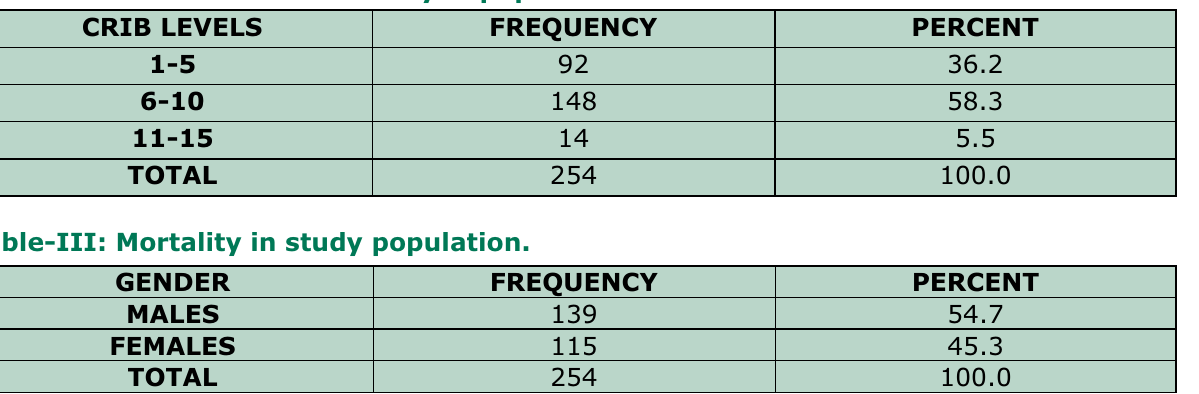
Table-IV: M  ean CRIB score among mortality and discharge group. MORTALITY